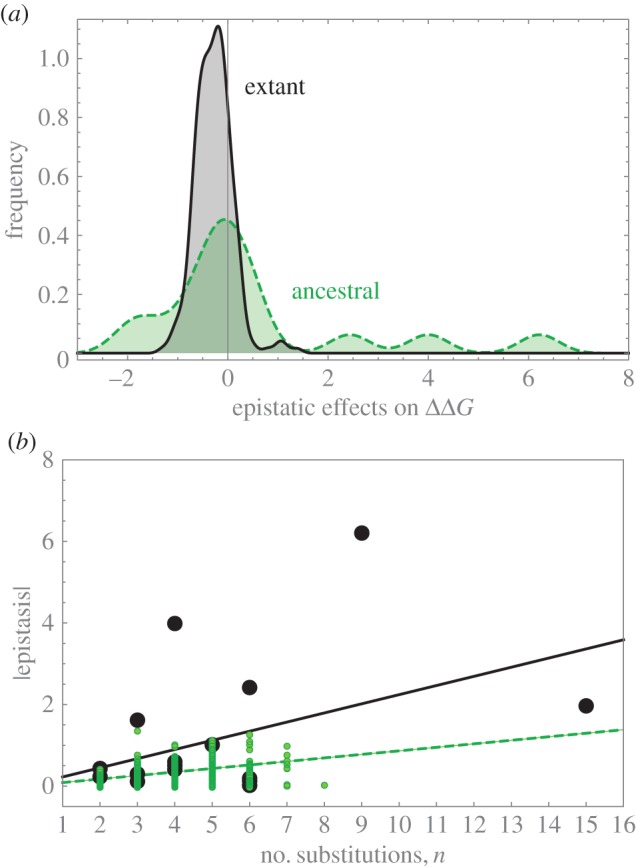
(a) Histograms of epistatic values. Solid line: extant species (mean = 0.48 kcal mol−1; variance = 4.39); dashed line: ancestral haplotypes (mean =−0.28 kcal mol−1; variance = 0.14). (b) Relationship between epistasis and the number of AA substitutions (n). Large bullets, extant species; small bullets, ancestral haplotypes. The lines are linear regressions. For the ancestrals (dashed line):  kcal mol−1; for the extant species (solid line):  kcal mol−1. Results from FoldX dataset. (Online version in colour.)